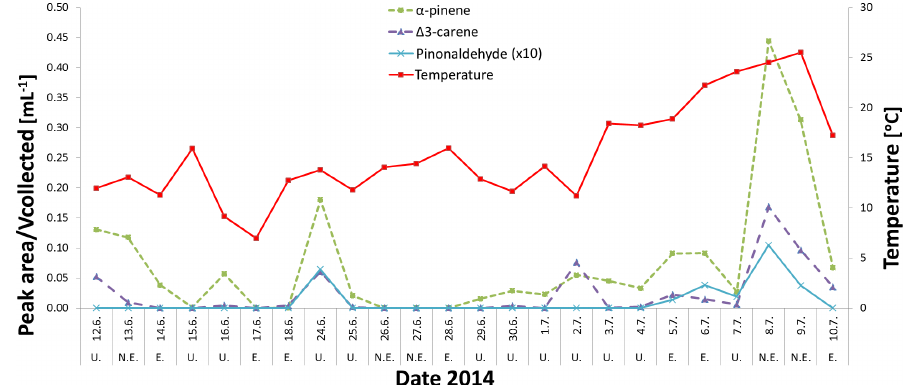
Figure 1. Comparison between the daily average amounts (peak areas/Vcollected) of α -pinene, (cid:49) 3 -carene and pinonaldehyde (Note the different scale for pinonaldehyde (10x)) collected by NTME and analysed by portable GC–MS in mid-summer 2014. (E. corresponds to a day when a nucleation event was observed, U. to an undefined event and N.E. to a day without nucleation events).